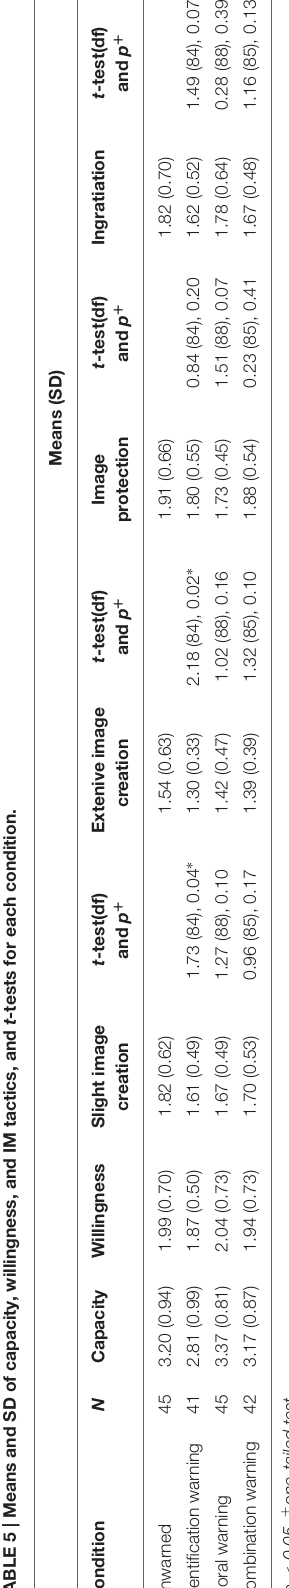
TABLE 6 | Means and SDs of applicant